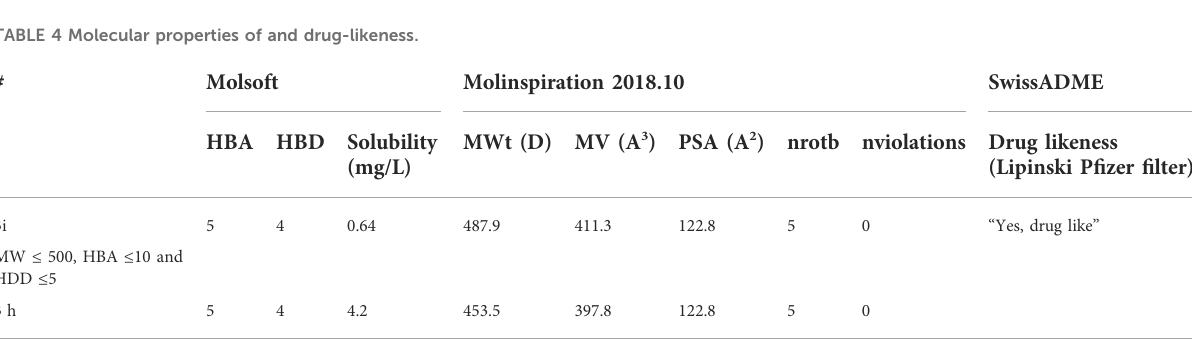
TABLE 4 Molecular properties of and